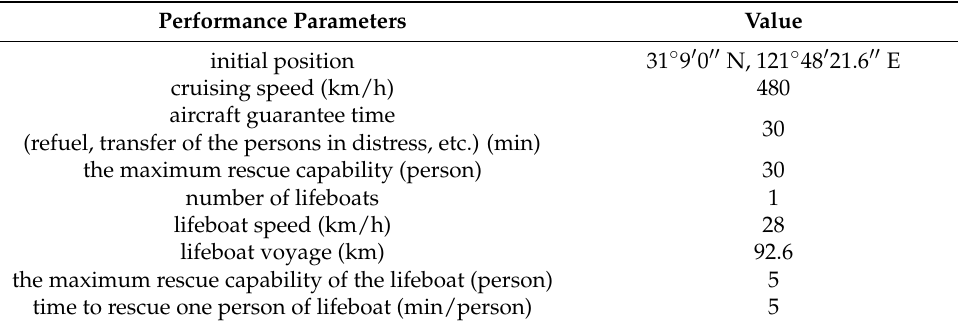
Table 1. Performance parameters of the amphibious